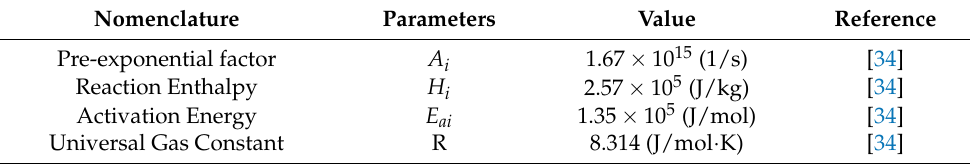
Table 4. Kinetic parameters used for the modelling of the